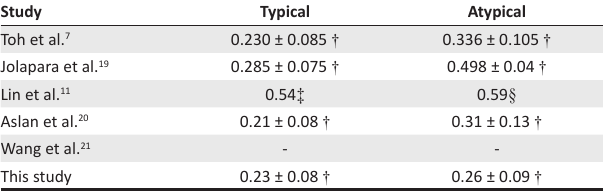
TABLE 5: A comparison between the mean fractional anisotropy values of typical and atypical meningiomas in previous studies and this study. Study